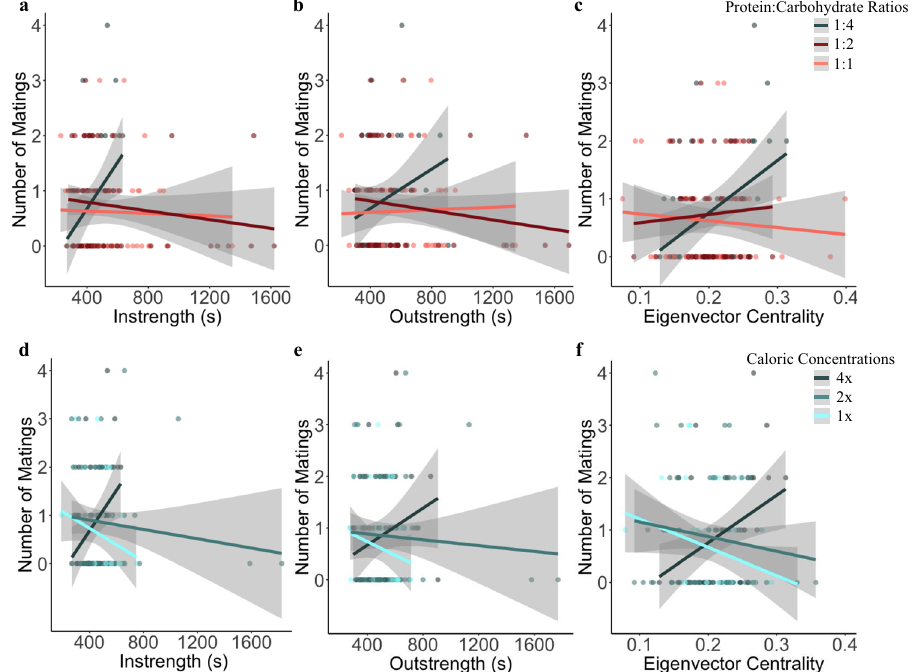
Fig. 3 Selection on network position is context-dependent. Selection gradients, quanti fi ed as the correlations between male mating success and three network position metrics measured the fi rst day after social groups were established, varied across nutritional environments that varied in protein: carbohydrate ratio ( a – c ) and caloric concentration ( d – f ). Lines show best fi t linear relationships with standard error (shaded areas) (1:4 – 1:1, 4x – 1x; n = 40, 60, 60, 40, 70, 50, respectively). The colors of each line correspond to the given protein:carbohydrate ratio or caloric concentration. Source data are provided as a Source Data fi